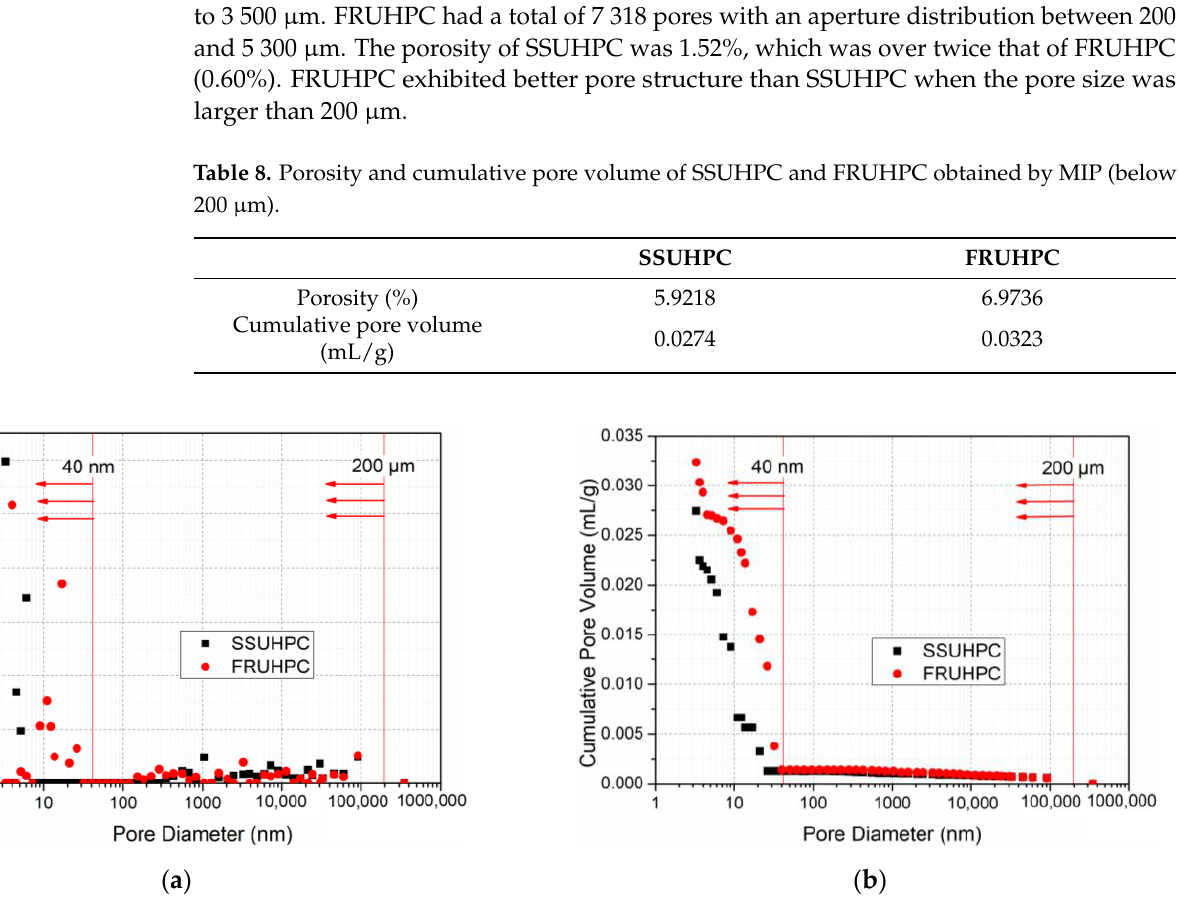
Figure 11. Comparison of pore structure characteristics below 200 μm: ( a ) Integral curve of pore diameter distribution; ( b ) Cumulative pore volume distribution curve. Table 8. Porosity and cumulative pore volume of SSUHPC and FRUHPC obtained by MIP (below 200 μm).